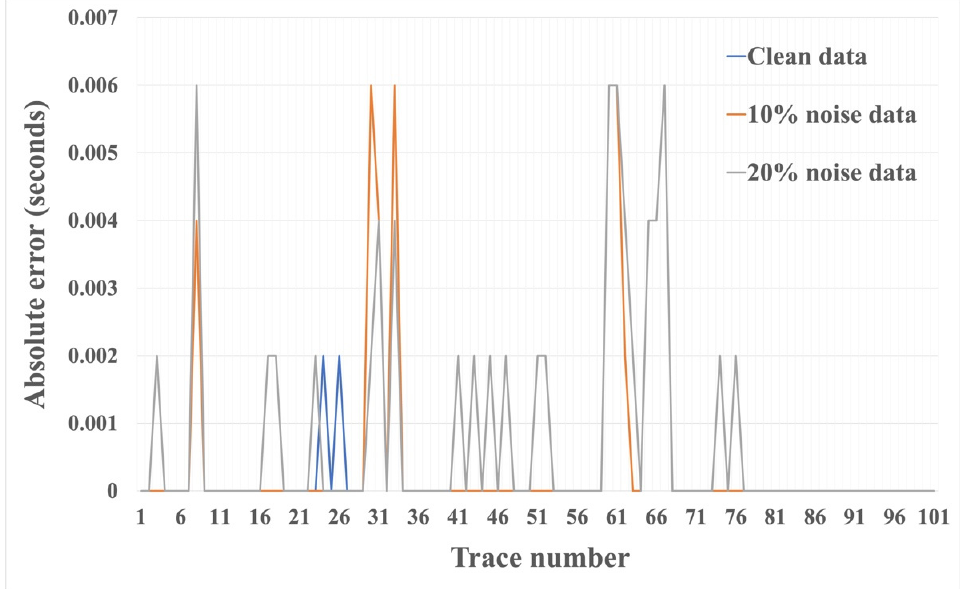
Figure 9. Absolute error between first arrival picks determined by the HEEH method and calculated from the model on the synthetic dataset.